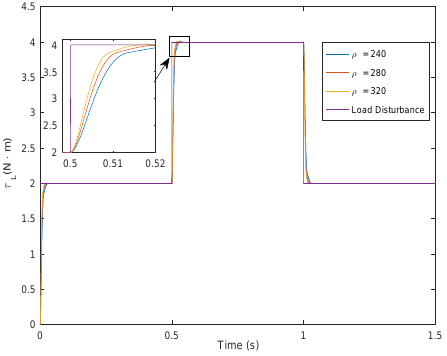
Figure 4. Simulation curve of load disturbance tracking based on the ESO.